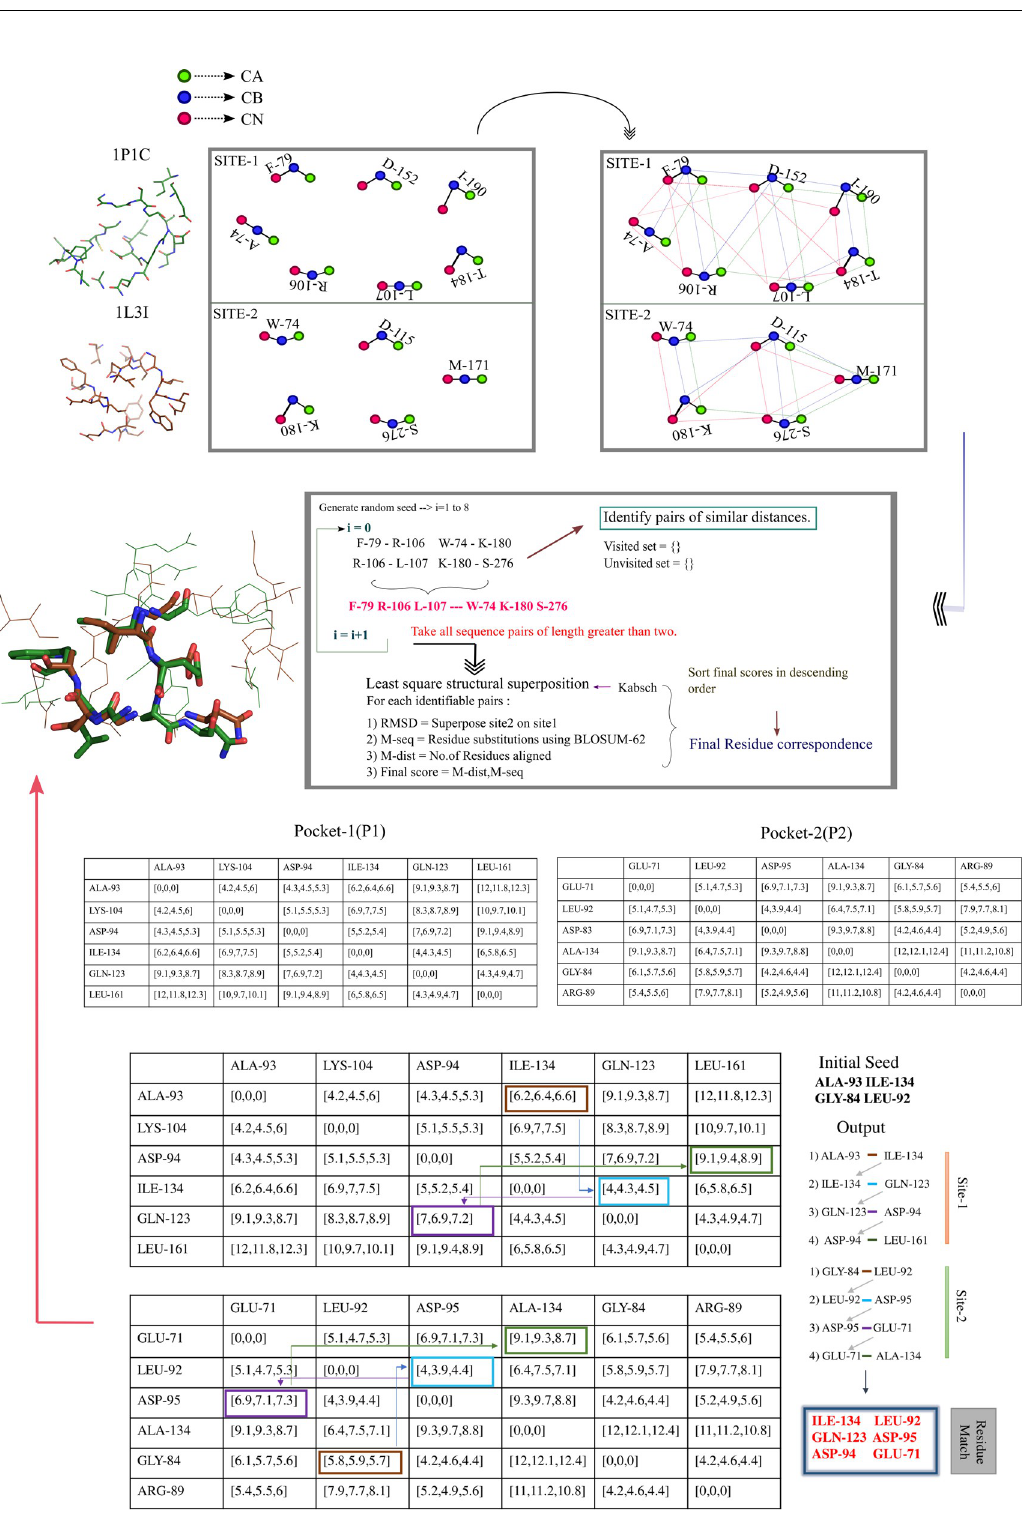
Fig 1. A depiction of the workflow of SiteMotif for an example pair of pockets P1 and P2. For each pocket, a distance matrix containing distances (c α -c α , c β -c β and cn-cn distances) for all residue pairs is constructed. For each element of P1, a scan is established against all elements of P2 and only those elements that are within 1 Å to the P1 seed are selected. All matched residue pairs are then sorted in descending order of their distance difference, which will serve as the input for the next iteration. The module is run in a recursive sequence order independent manner for each element of P1 against all elements in P2.